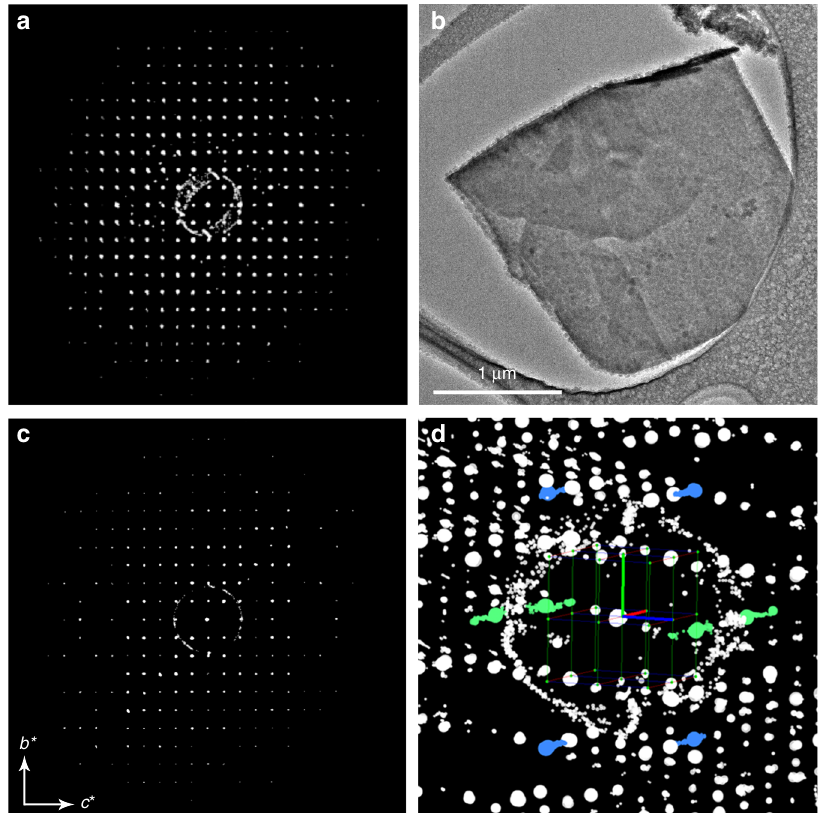
Fig. 1 Electron microscopy-based structure determination of DCPM. a The reconstructed three-dimensional reciprocal lattice from continuous rotation electron diffraction data collected from ( b ) a crystal of DCPM can be indexed by a monoclinic unit cell. c Section through the reconstructed reciprocal lattice showing the 0kl family of re fl ections. Systematic extinctions can be observed for 0k0 and 00l families of re fl ections which is consistent with the space group P 2 1 /c . Further details on the symmetry deduction can be found in Supplementary Figs. 3 and 4. d Enlarged part of the 3D reconstructed reciprocal lattice shows some diffuse scattering running along the a* -axis, here, the a* , b* , and c* -axes are indicated by red, green and blue vectors, respectively. The 121 re fl ection with surrounding diffuse scattering and its symmetry related equivalents are marked in blue and the h02 line is marked in green. The diffuse circles in a , c , and d are due to diffraction from small ice crystals formed under liquid nitrogen cooling conditions. Source data are provided as a Source Data fi